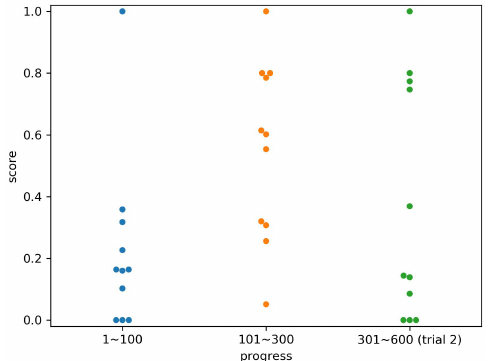
Figure 15. Scores of Subject 5 by time period.